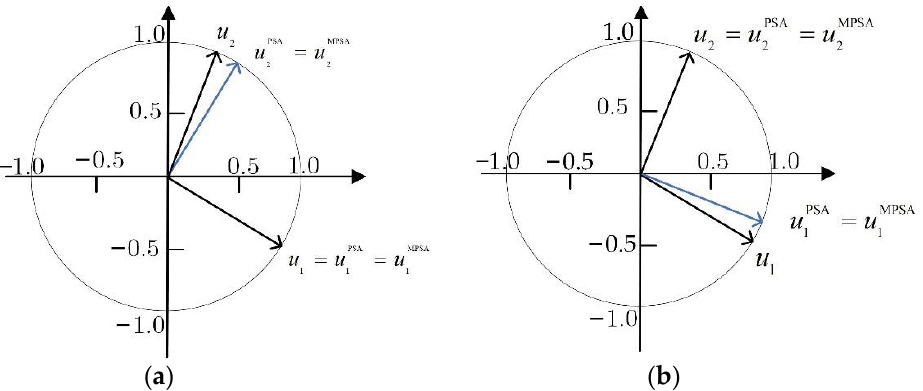
Figure 2. The distribution of two true eigenvectors, and those obtained by PSA and MPSA in a unit circle. ( a ) The first result was obtained with PSA and MPSA; ( b ) the second result was obtained by PSA and MPSA.